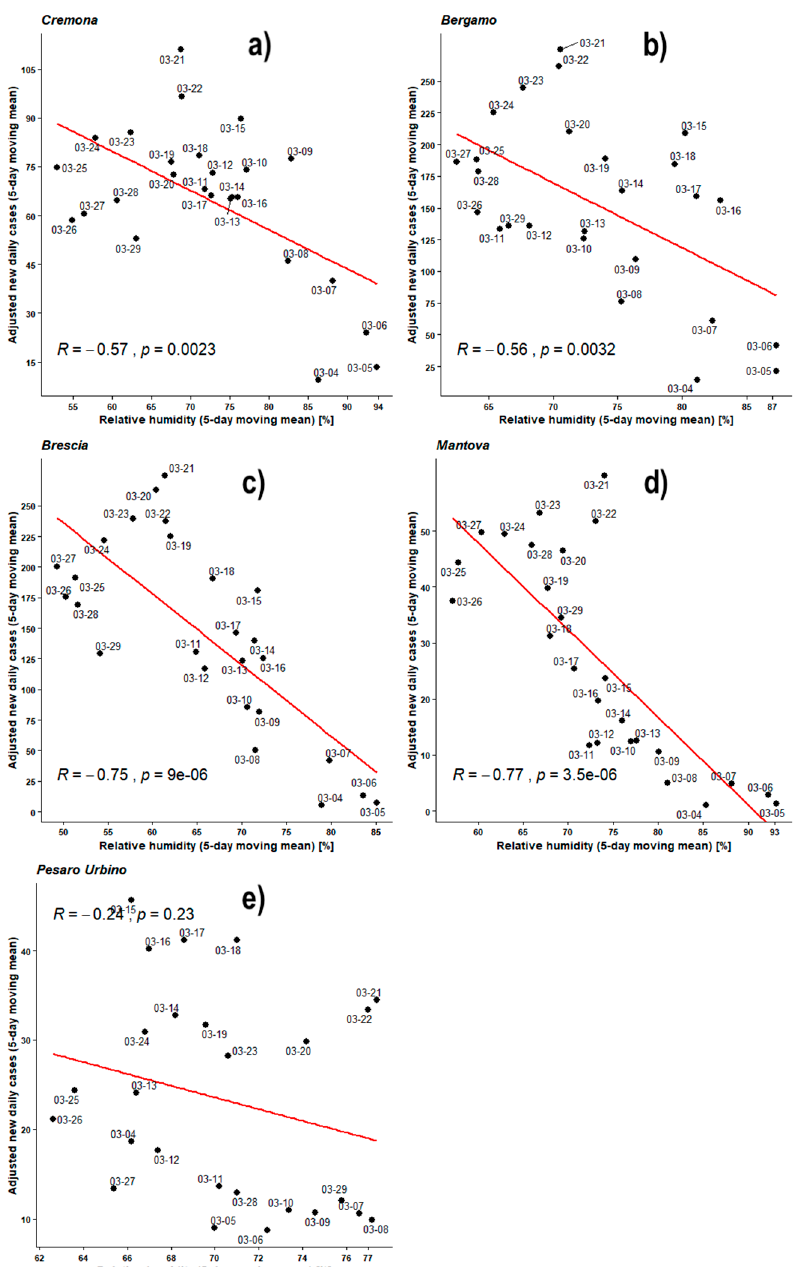
Figure 9. Scatter plot and linear regression for the 5-day moving means of adjusted new daily cases of COVID-19 against relative humidity for five Italian provinces: ( a ) Cremona, ( b ) Bergamo, ( c ) Brescia, ( d ) Mantova, ( e ) Pesaro Urbino. Labels report, in MM-DD format, the last day of the moving means. Pearson correlation coe ffi cient is reported as ‘R’ while probability value is reported as ‘ p ’.